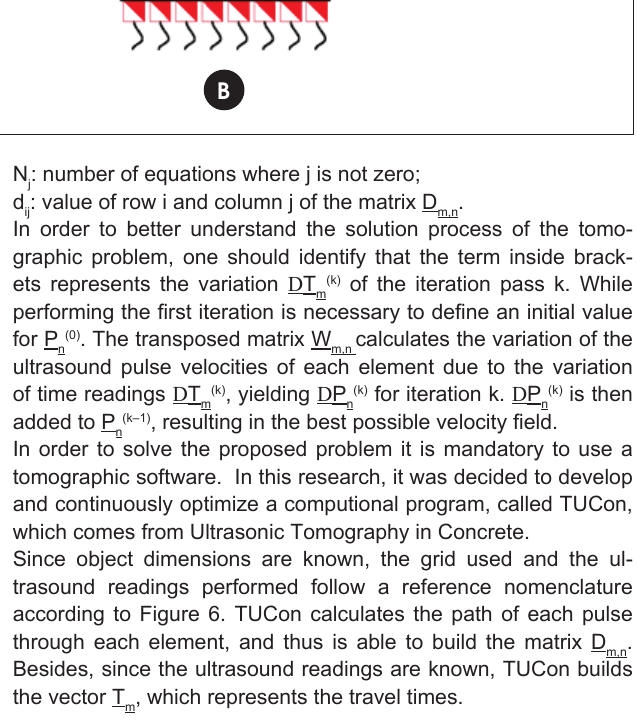
Figure 6 – Measurement points for two dimensional